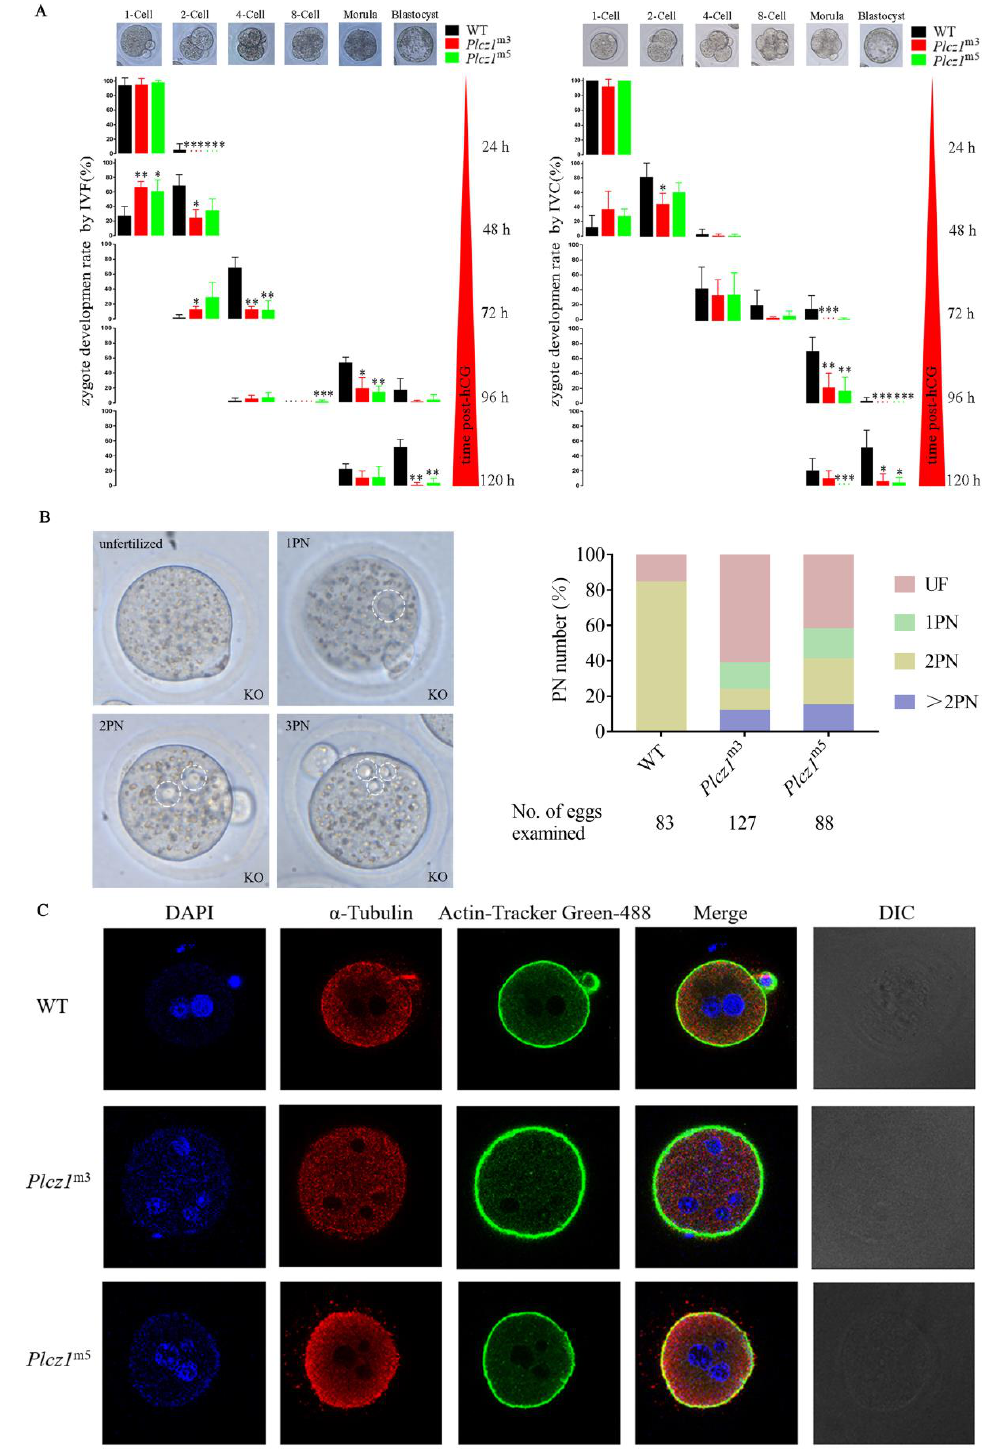
Figure 2. Delayed early embryonic development caused by sperm with Plcz1 deletion is associated with polyspermy. ( A ) Early embryonic development of Plcz1 m5 and Plcz1 m5 offsprings after IVC or IVF in Plcz1 − / − mice compared with WT, * p < 0.05, ** p < 0.01, *** p < 0.001. ( B ) Oocytes with different numbers of pronuclei were analysed after observation under a microscope at 12 h post-coitus. Dotted circles indicate pronuclei. ( C ) After staining with DAPI, the number of pronuclei (PN) were observed in eggs fertilised with sperm of Plcz1 − / − mice under fluorescence microscopy (Scale bar = 20 µ